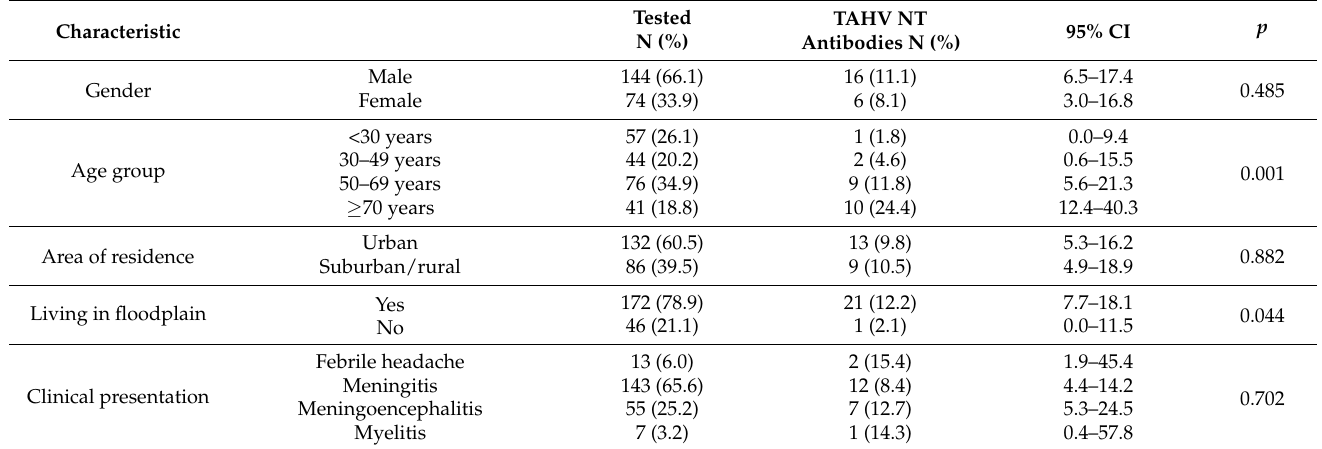
Table 4. Prevalence of TAHV NT antibodies according to patients’ demographic and clinical characteristics.